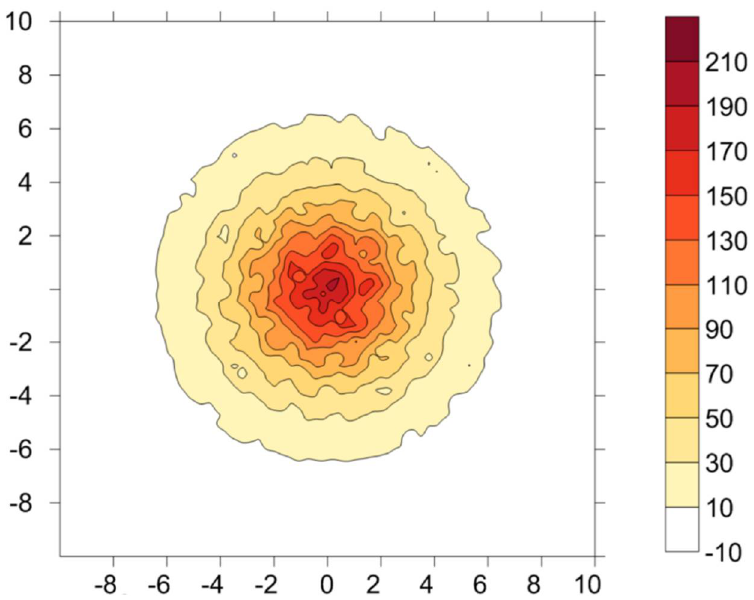
Figure 9. Radiative flux map in W/cm 2 calculated at the focal plane, related to all lamps; the coor-